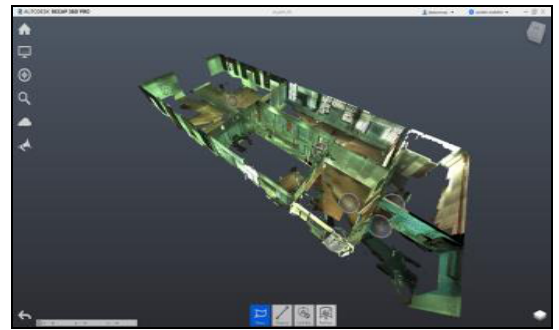
Figure 12. Cleaned data from TLS